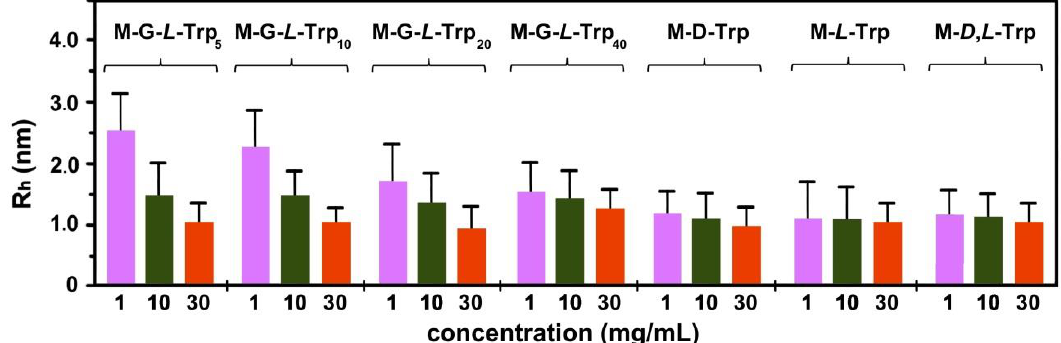
Figure 6. Hydrodynamic radius of M-G- L -Trp copolymers in the 1–30 mg · mL − 1 range. Data were recorded in 0.1 M NaCl at pH 8 and 25 °C.